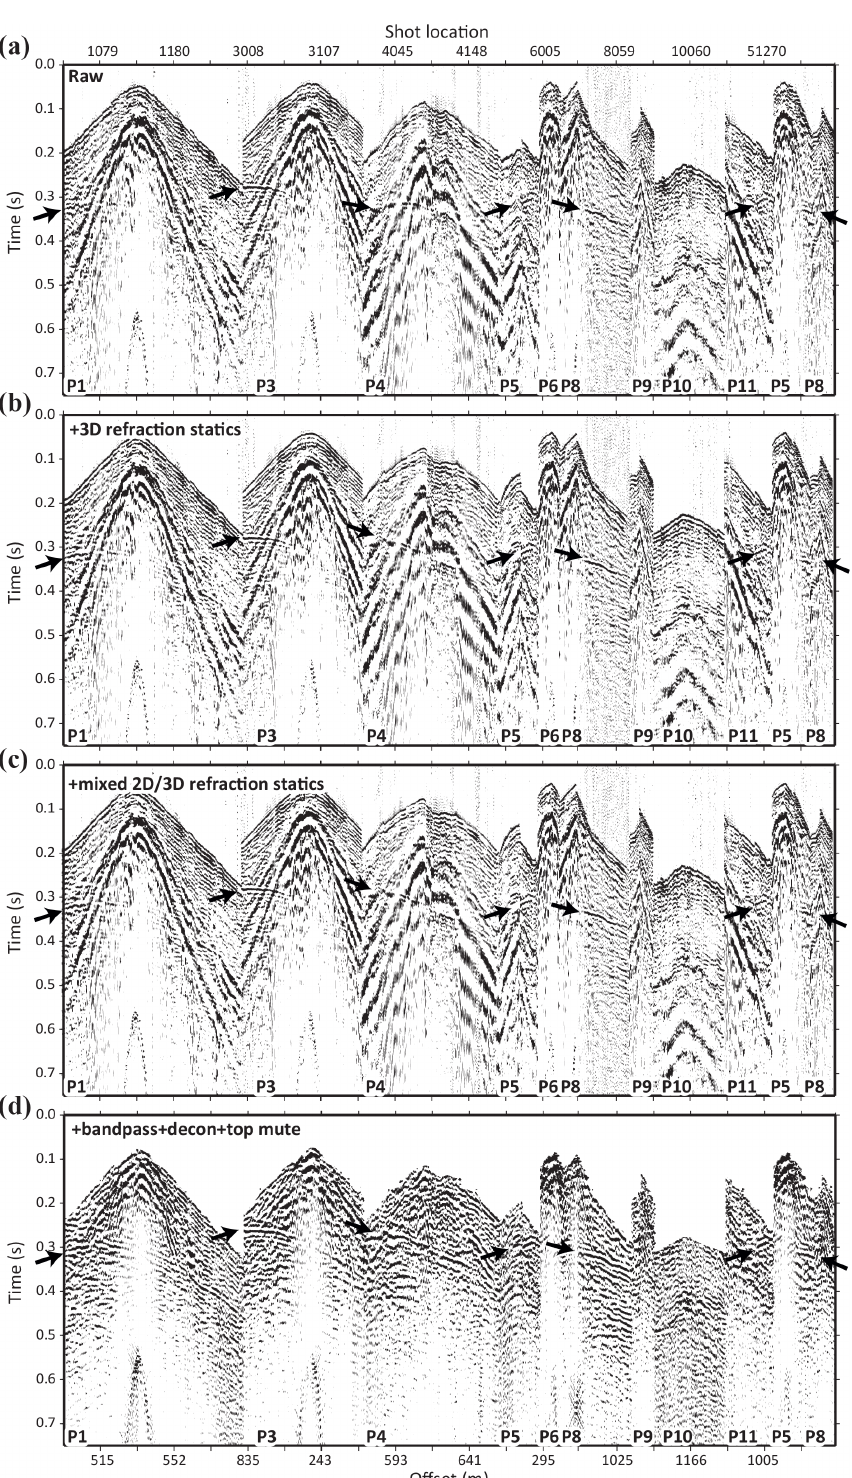
Figure 8. (a) An example of raw receiver gather along P2 after (b) 3D static corrections; (c) mixed 2D and 3D static corrections (used for processing; and (d) bandpass filter, deconvolution, and top mute. Note the increase in the signal quality and especially the coherency of the reflections marked using the arrows (we expect these to be from the mineralization observed on the earlier 2D surveys and downhole logging data). Note that shots are only sorted based on their peg numbers as the in-between receivers were shot and named differently (multiplied by 10, e.g. 51270 is a shot along P5 and at the position between 5127 and 5128).